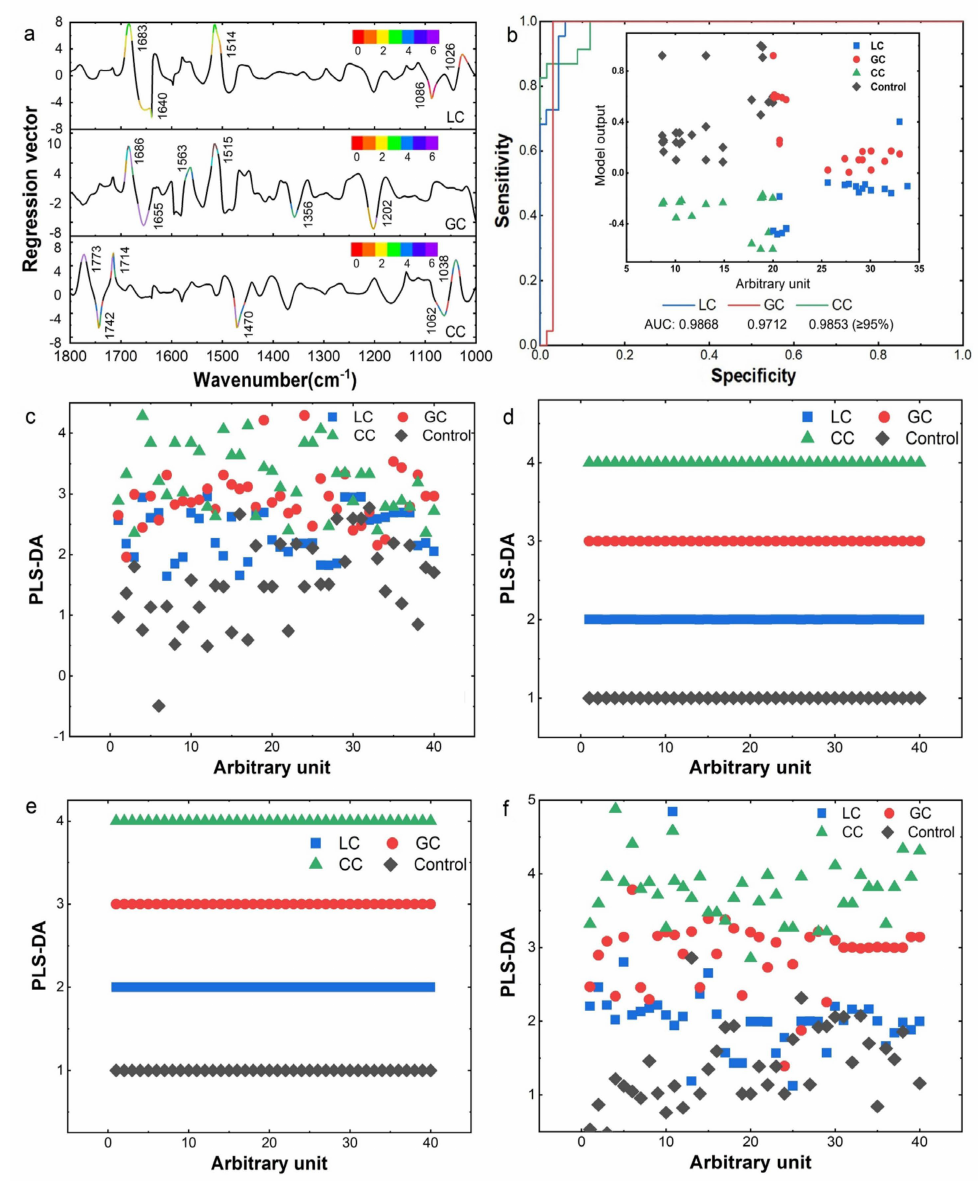
Figure 3. Classification performances of the PLS-DA model for each DTCs vs. controls. ( a ) Regression vectors for LC, GC, and CC classification, respectively. Different ranges of VIP values are shown in different colors. VIP = variable effect on projection. ( b ) ROCs plot of DTC samples (external) versus model output (internal). AUC = area under the curve. ( c ) 3300–2800 cm − 1 (mainly caused by lipid hydrocarbon chains), ( d ) 1700–1600 cm − 1 (protein amide I bands), ( e ) 1500–1400 cm −